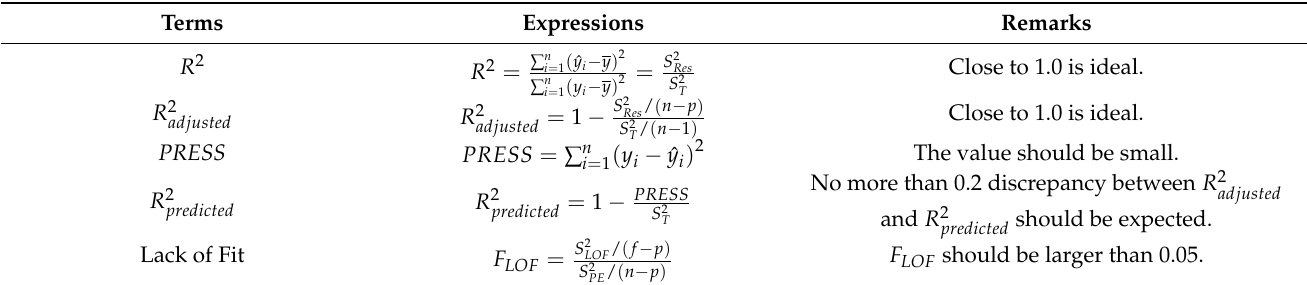
Table 7. Expressions used for model verification.